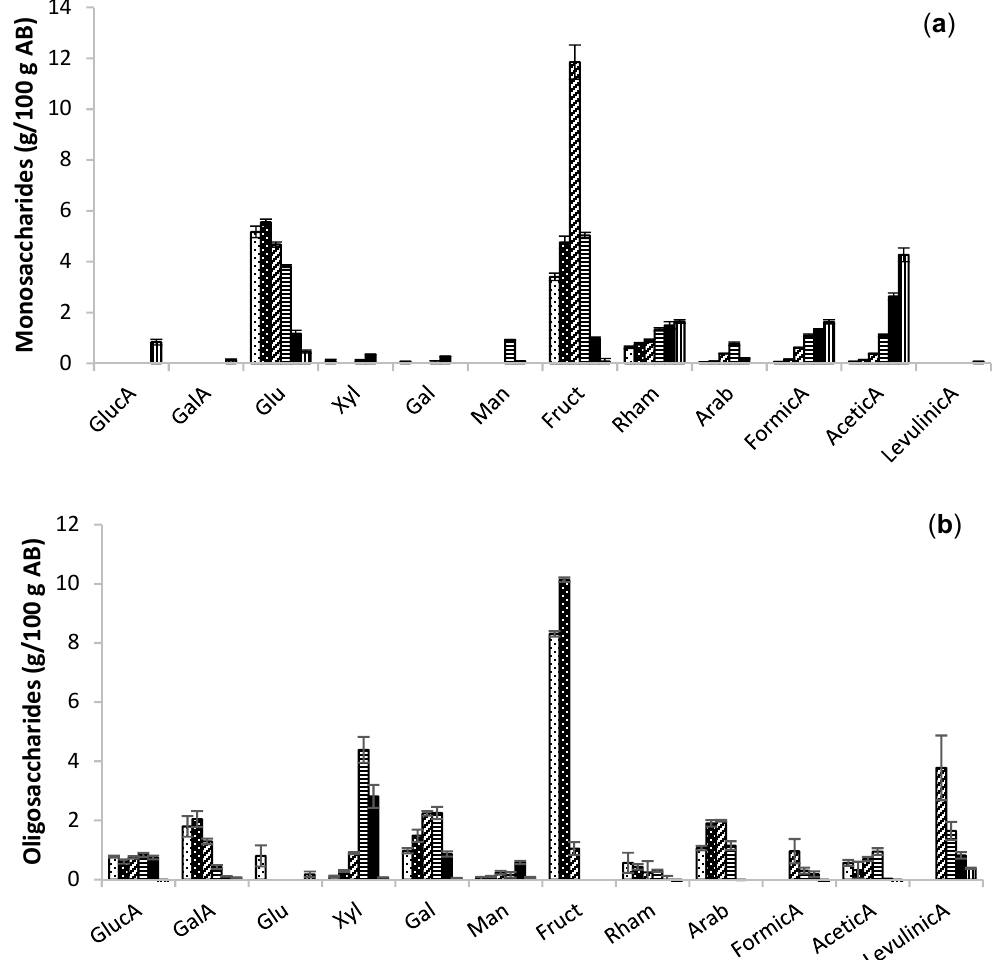
Figure 3. Extraction of ( a ) monosaccharidic and ( b ) oligosaccharidic fractions of extracts obtained at different temperatures; 140 (black dots), 160 (white dots), 180 (slanted lines), 200 (horizontal lines), 220 (filled bars), and 240 °C (vertical lines) of conventional heating.